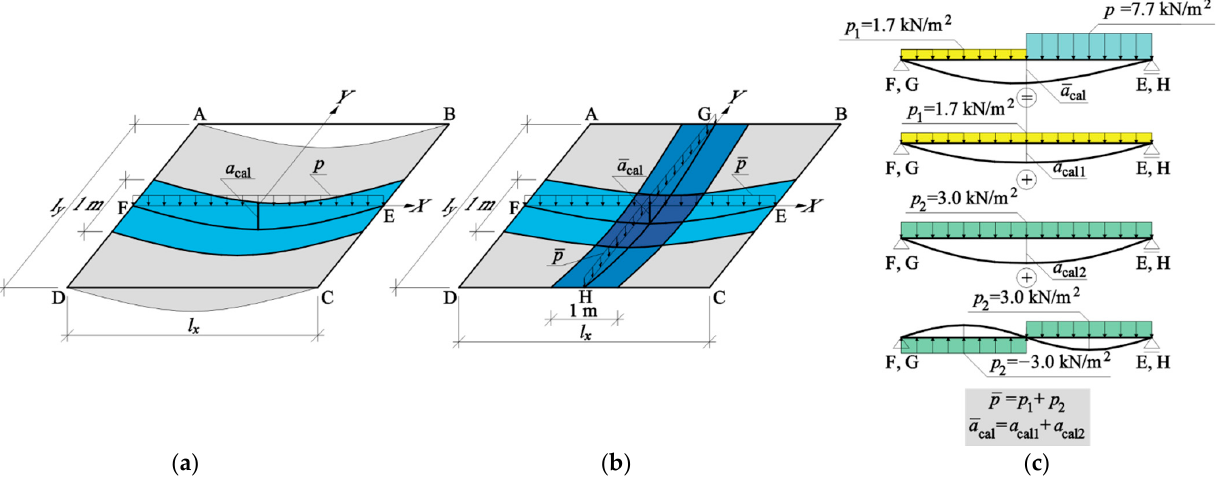
Figure 21. Slab models used in calculations: ( a ) the beam model; ( b ) the slab model; ( c ) the principle of establishing the equivalent loading of the slab p (cid:3364) under non-symmetric loads.